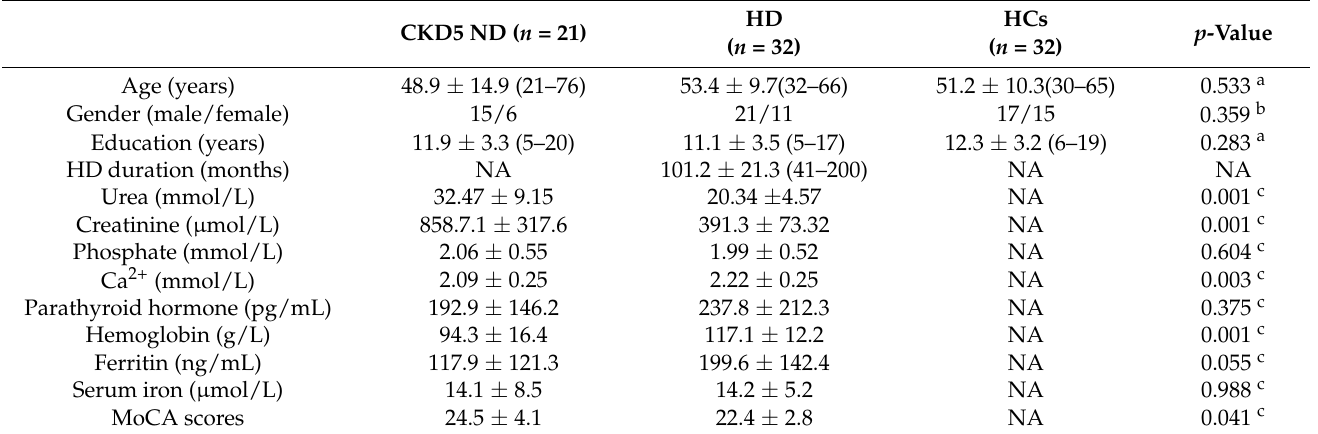
Table 1. Demographic and clinical characteristics of the